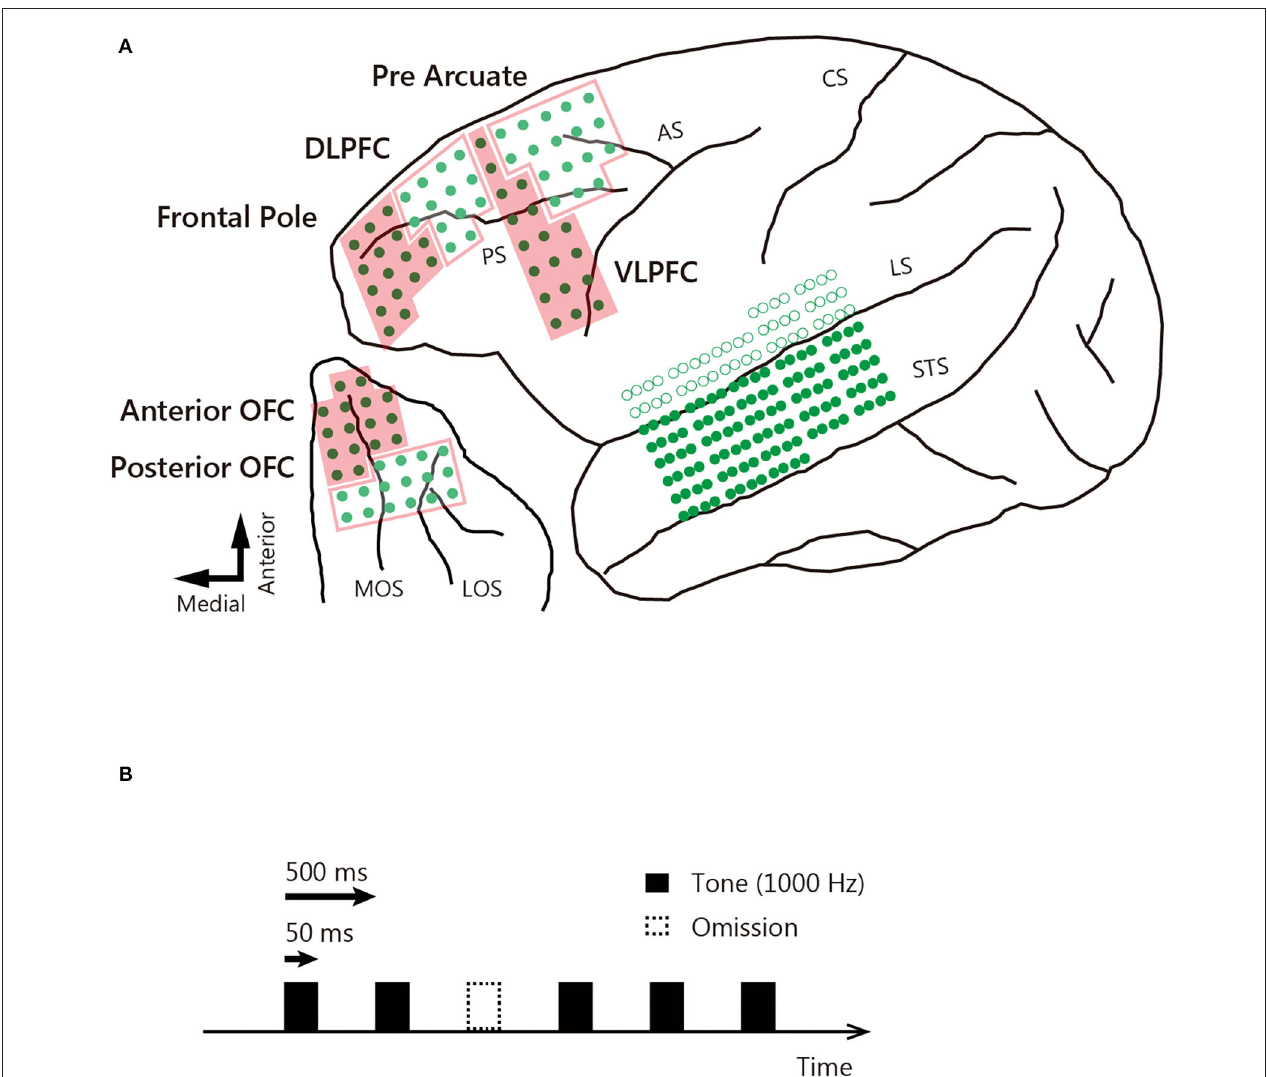
FIGURE 1 | Locations of ECoG electrodes and auditory stimuli. (A) The ECoG electrodes covered the left hemisphere, and the exact locations were determined in monkey D on postmortem brain reconstruction. Green dots indicate electrodes located on the surface of the brain, and circles are electrodes inserted into the lateral sulcus. Arrows correspond to the direction of the lower left panel. STS, superior temporal sulcus; LS, lateral sulcus; CS, central sulcus; AS, arcuate sulcus; PS, principal sulcus; MOS, medial orbital sulcus; LOS, lateral orbital sulcus. (B) Auditory stimuli (1,000Hz, 50ms duration tone) were presented with a stimulus interval of 500ms. Ten percent of the auditory stimuli were omitted. Black bars indicate tone presentation, and dotted bars indicate tone